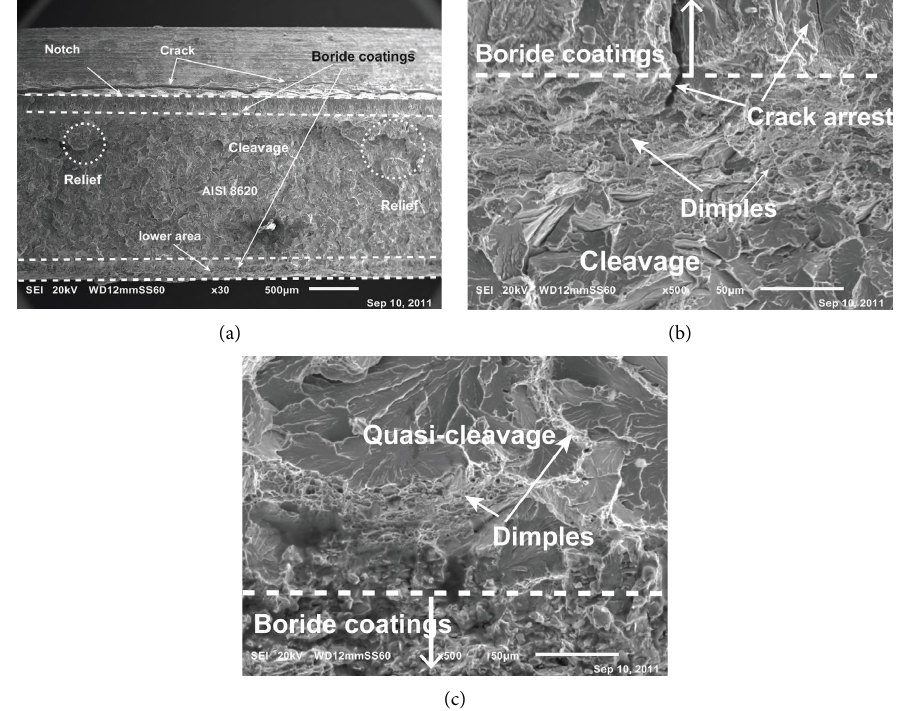
Figure 11: SEM fracture surface images AISI 8620 borides at 1223K for 6h with hydrogen charging: (a) general view of the surface, (b) area close to the notch, and (c) lower area of the